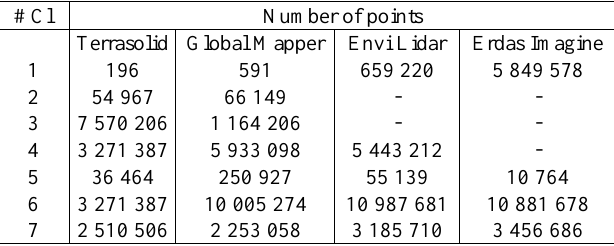
Table 2. Number of points in each class for different